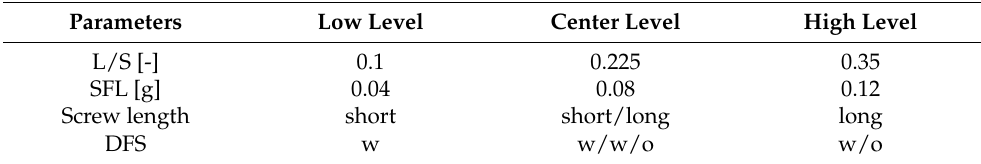
Table 2. Two-level full factorial design of experiment (DoE) parameter space. L/S, liquid-to-solid ratio; SFL, specific feed load. DFS, distributive feed